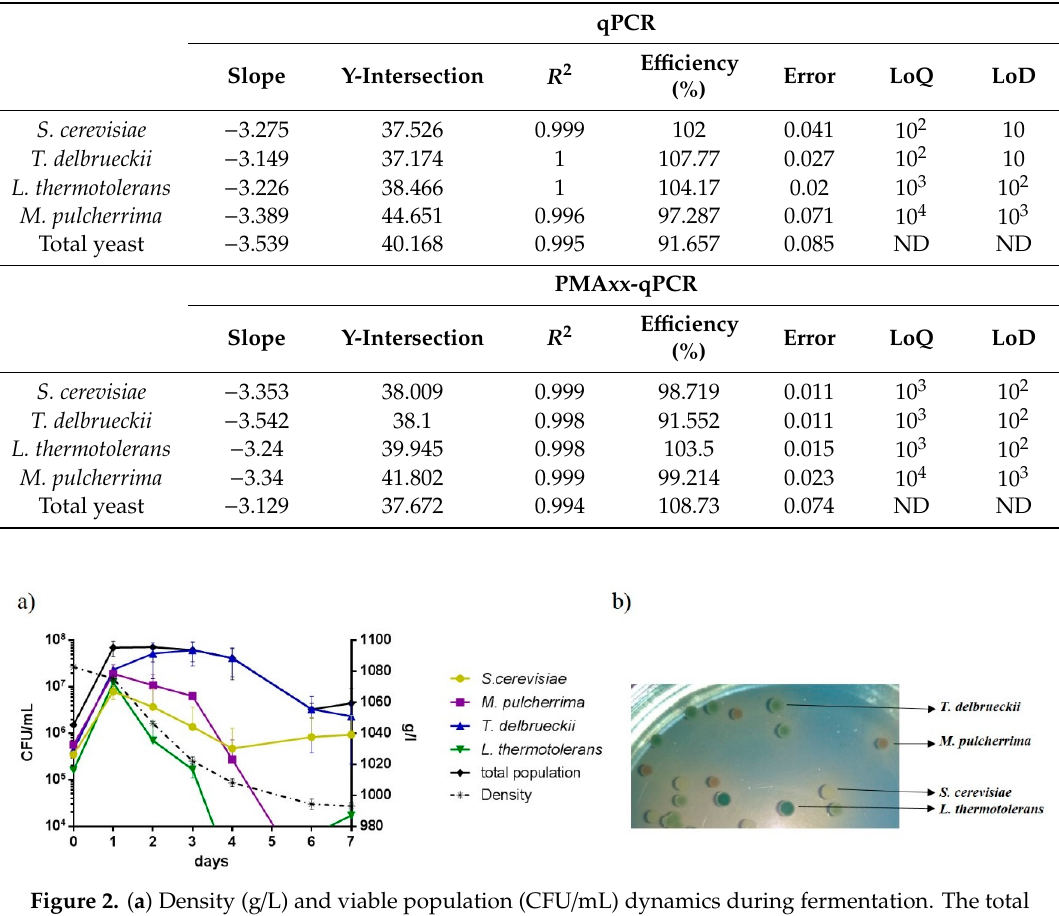
Table 2. Slopes, Y-intersections, correlation coe ffi cients ( R 2 ), e ffi ciencies (%), standard errors, limits of quantification (LoQs) and limits of detection (LoDs) of standard curves obtained from serially diluted DNA of S. cerevisiae , T. delbrueckii , L. thermotolerans , M. pulcherrima and total yeasts, with or without the